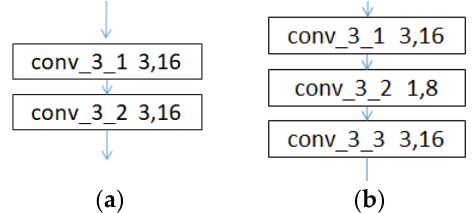
Figure 3. Comparison of different structures: ( a ) Dimensionality reduction without performing a 1 × 1 convolution; ( b ) Dimensionality reduction by performing a 1 × 1 convolution.